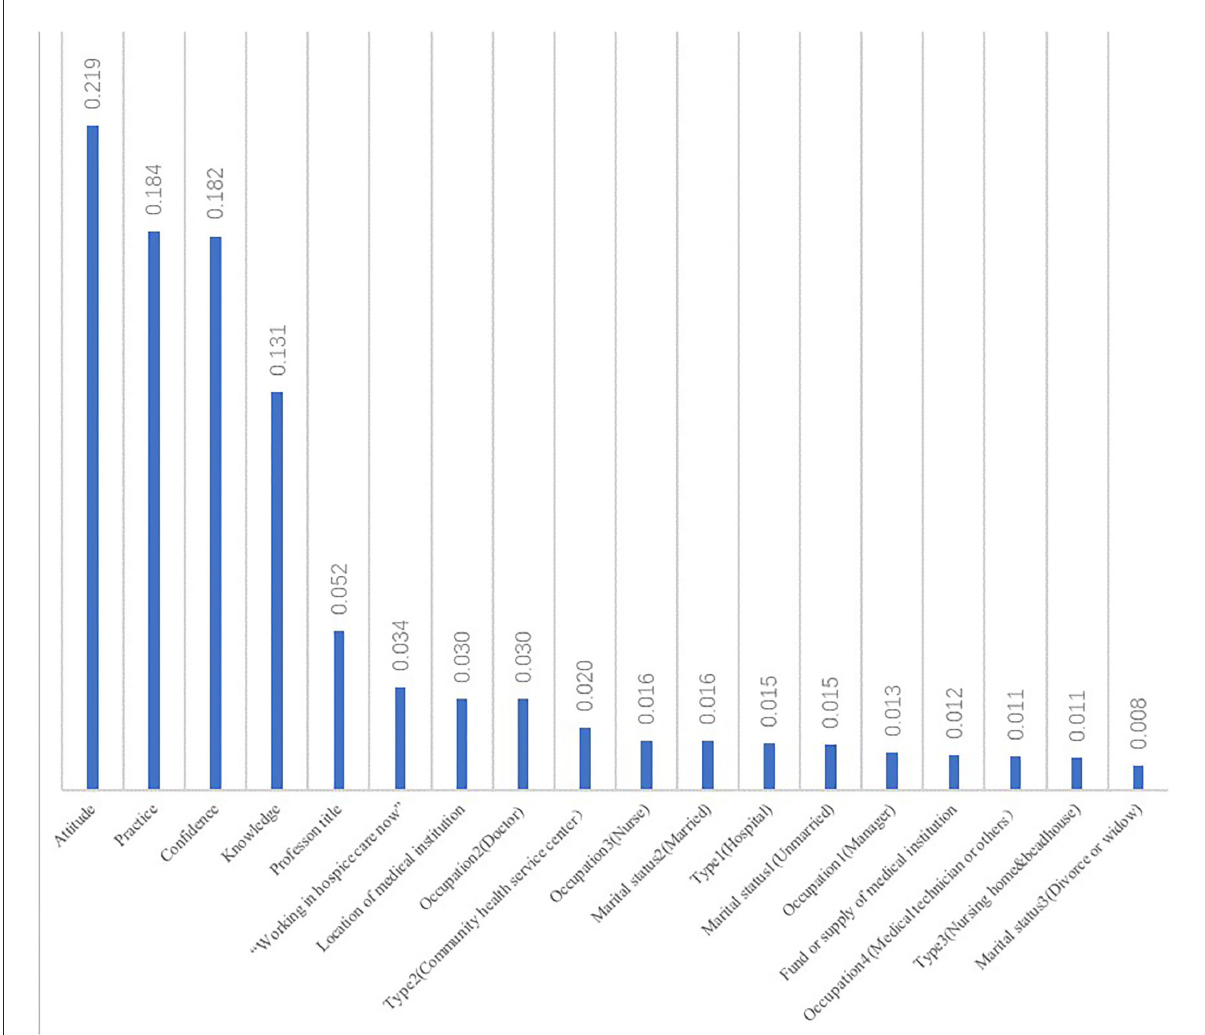
FIGURE5 Feature importance. It shows how important the value was in the